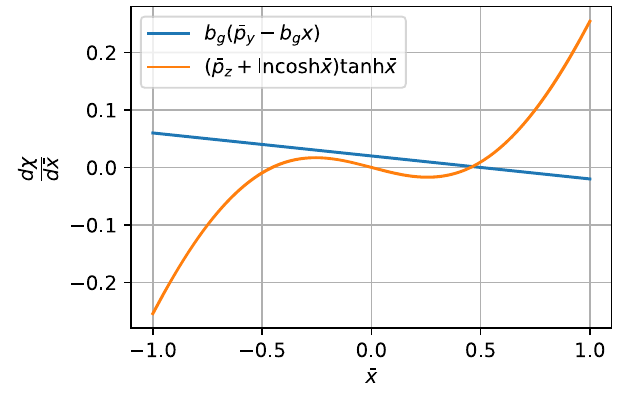
d-- -- -- x for p y = 0 : 1, p z = (cid:2) 0 : 1, and ð x Þ ¼ b ð (cid:2) p (cid:2) b Þ and f ð x Þ ¼ ð (cid:2) p þ lncosh (cid:2) x Þ tanh x 2 g y g x z